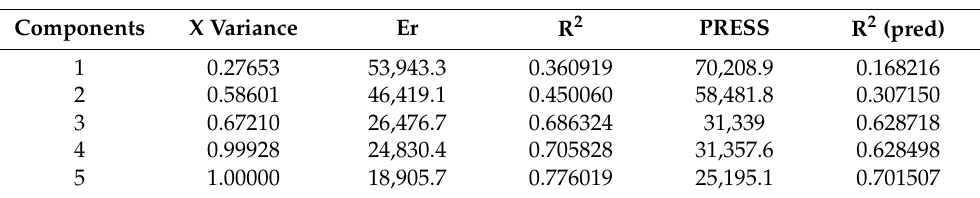
Table 6. Regression coe ffi cients for the q u max model.